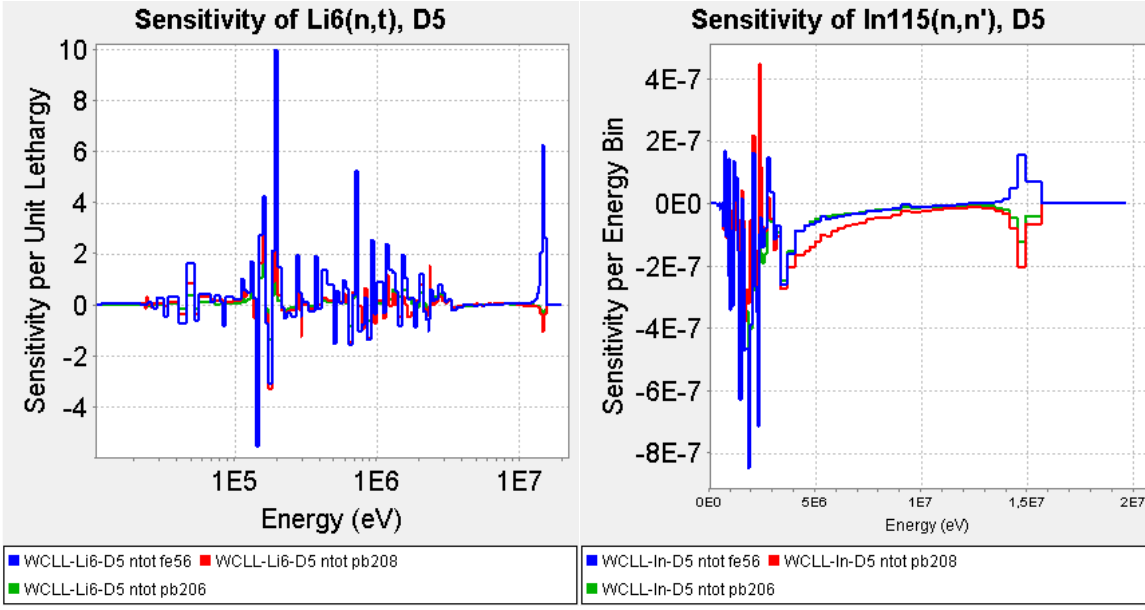
Figure 2: Examples of sensitivities of the 6 Li(n,t) and 115 In(n,n’) reaction rates at the position D5 (46 cm in the block) with respect to the Pb and Fe total cross